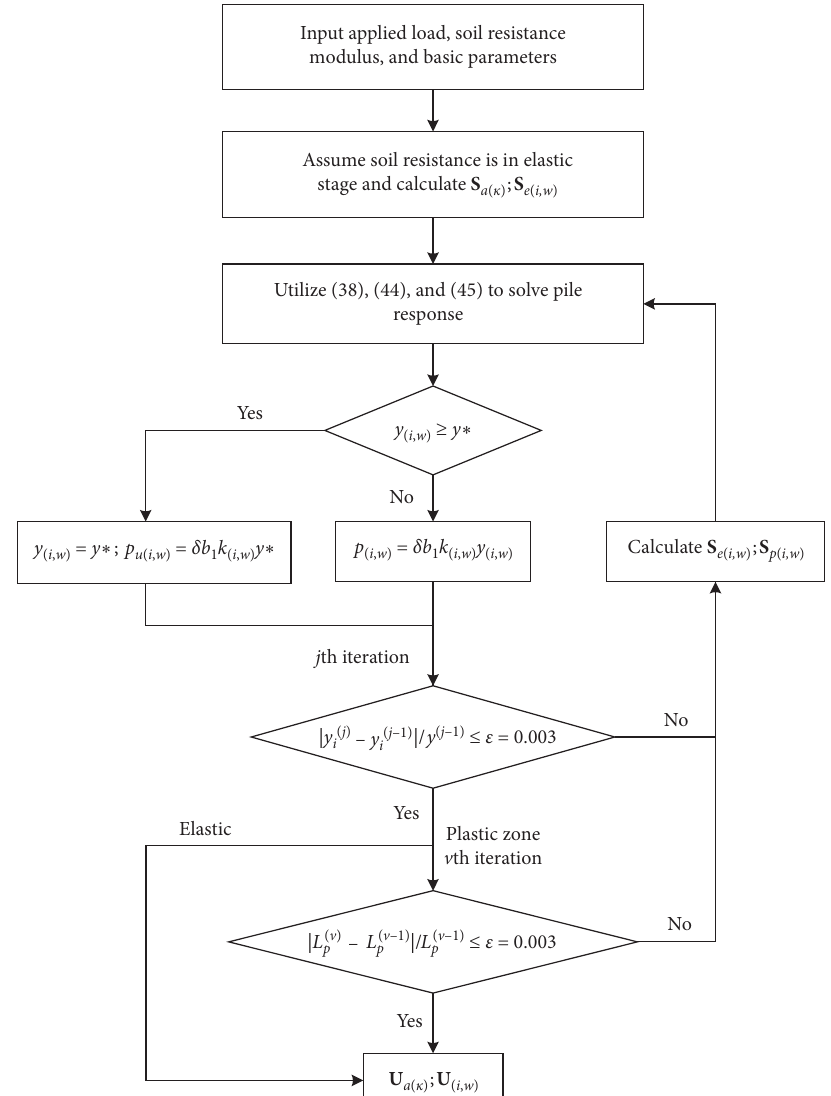
Figure 4: Algorithm to estimate the response of passively loads piles adjacent to a surcharge load.